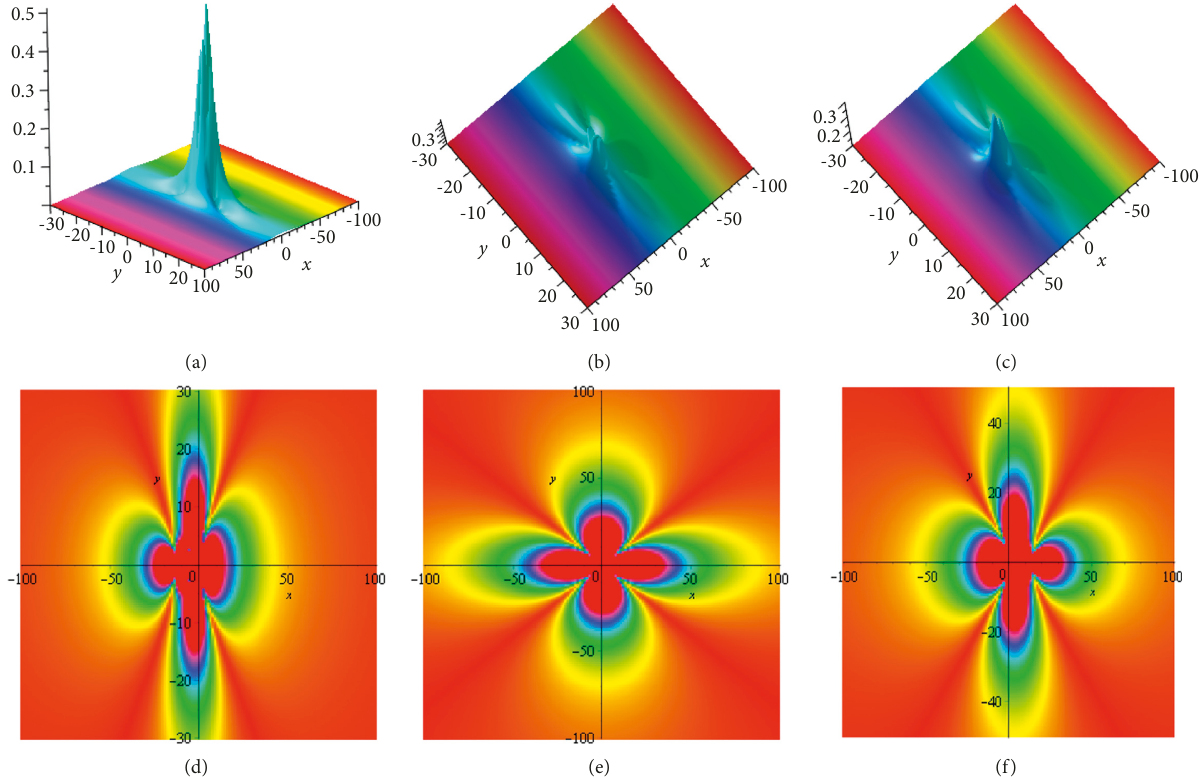
( t ) � 1 , ϕ ( t ) � cos ( t + 3 ) , c 1 9